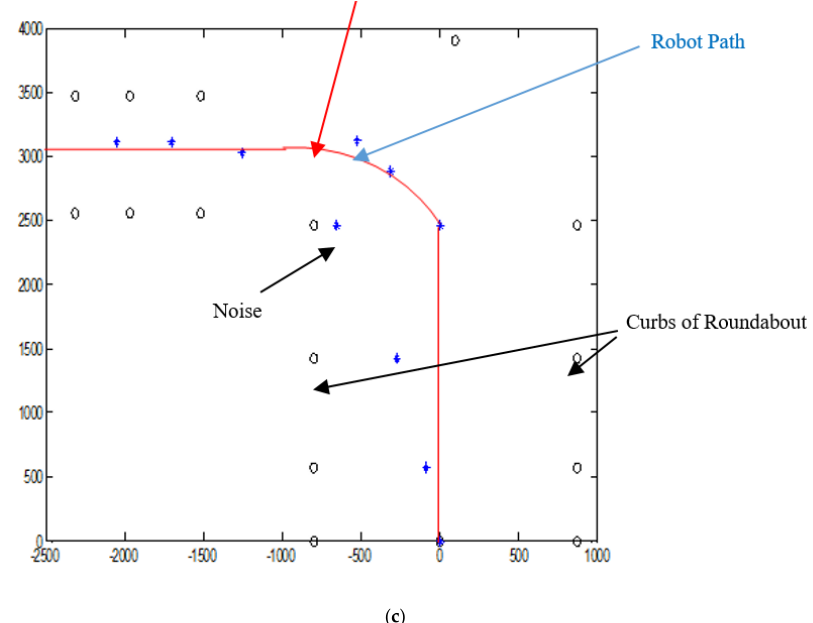
Figure 26. Robot path during navigation in a roundabout with 270° rotation. Note that blue ‘*’ denotes the path, and black ‘O’ signifies the road environment for: ( a ) 270° rotation, ( b ) 180° rotation, and ( c ) 90° rotation.